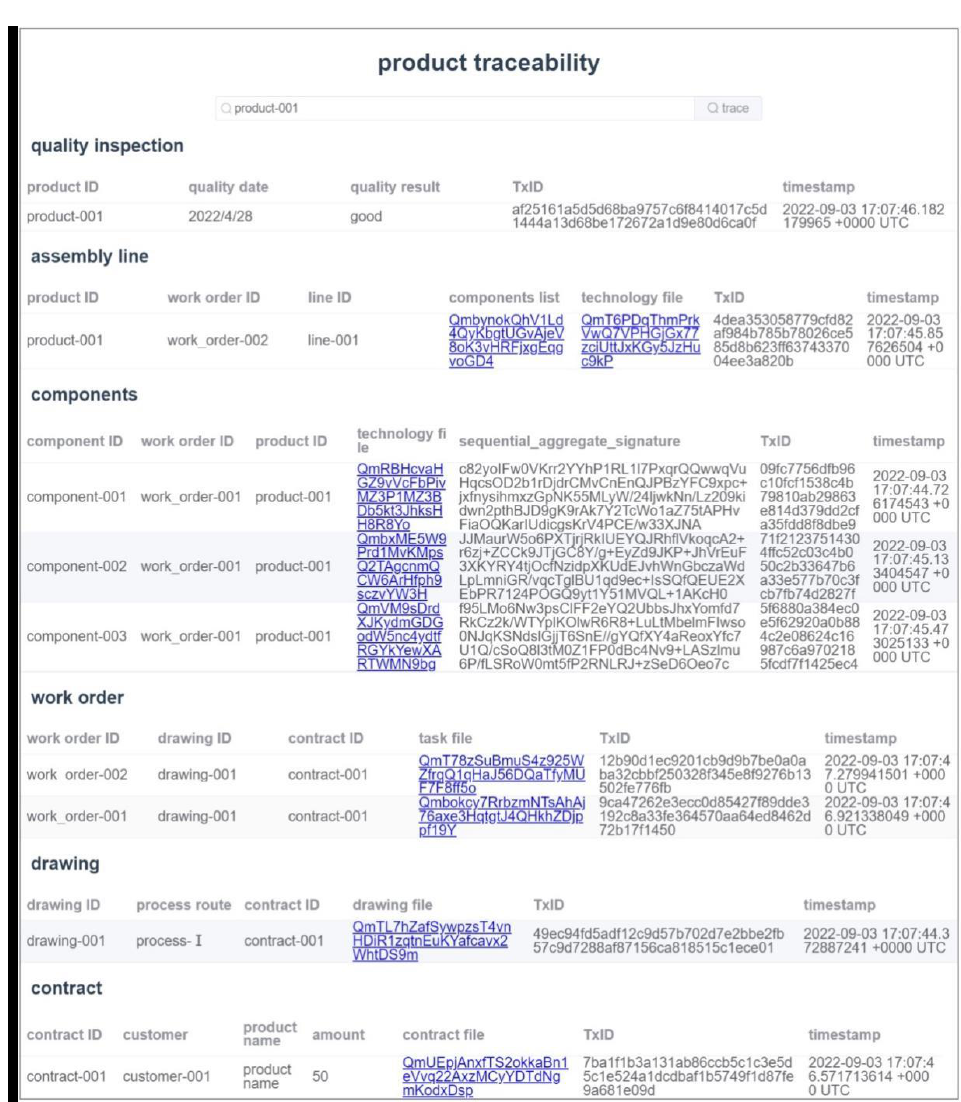
Figure 8. Data list of traceable products.